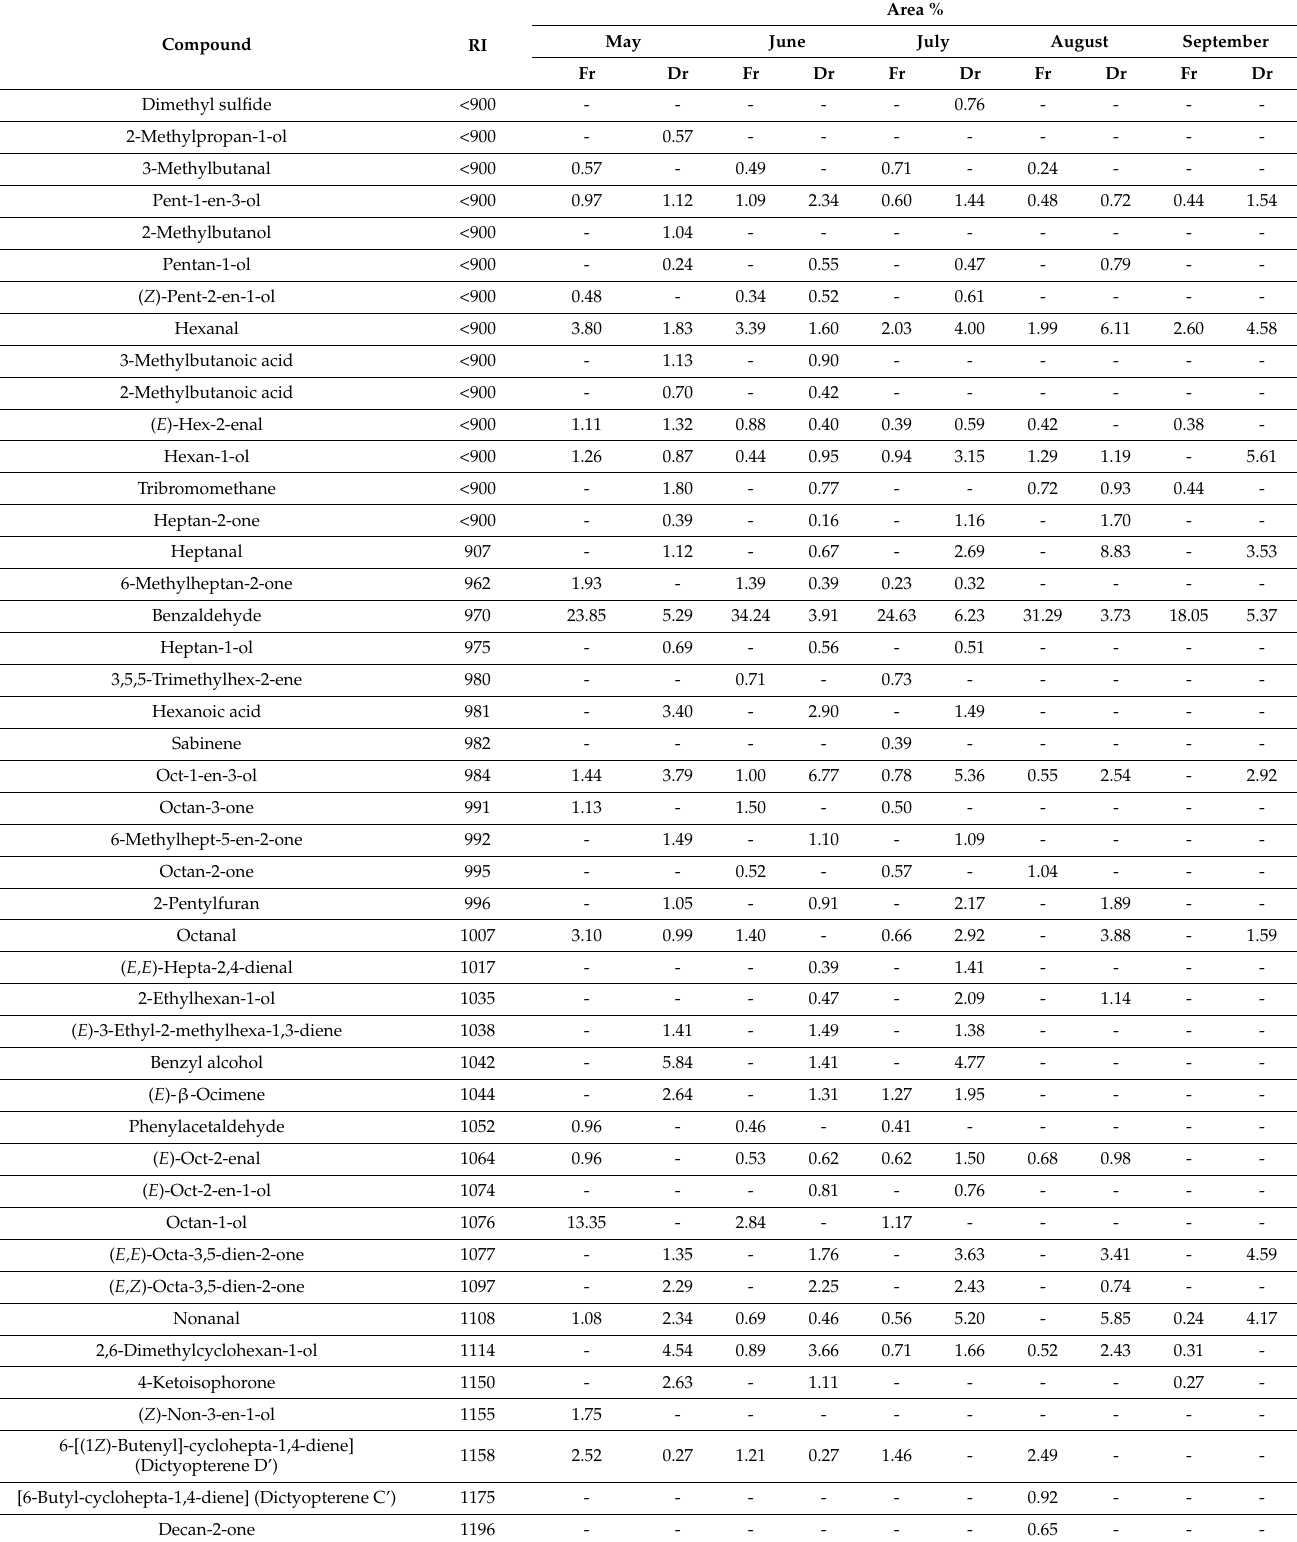
Table 1. The volatile compounds from H. scoparia isolated by headspace solid-phase microex- traction (HS-SPME) and analysed by gas chromatography–mass spectrometry (GC–MS) using DVB/CAR/PDMS fibre (f1); Fr (fresh), Dr